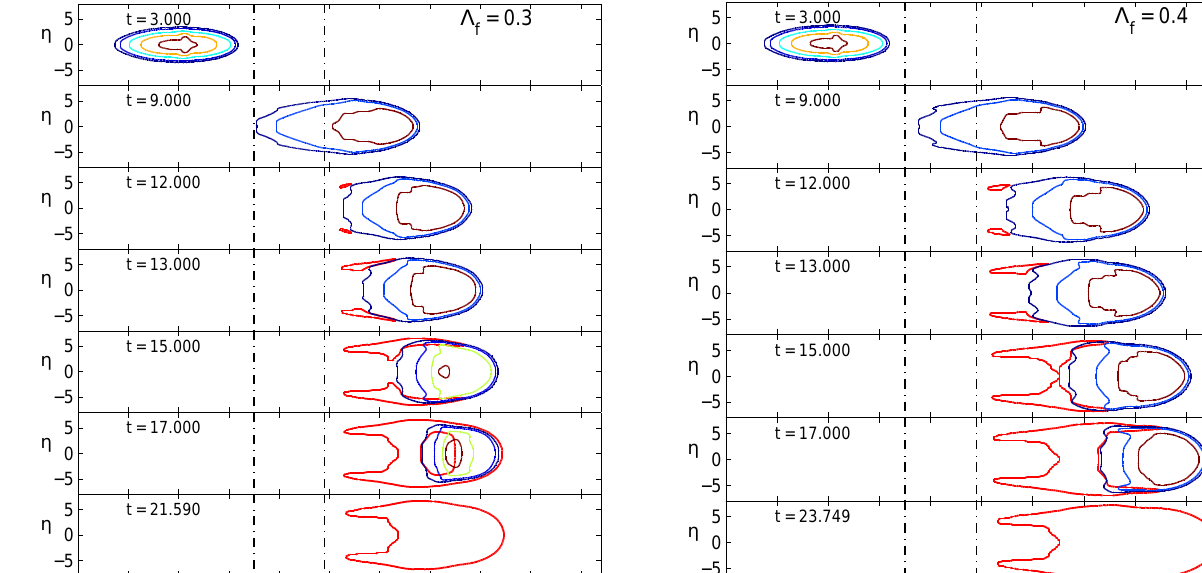
Fig. 6. Contour plots of the flowing mass and the evolution of the deposition heap, where Λ f = 0 . 3 with the deposition procedure be- ing adopted in the computation.